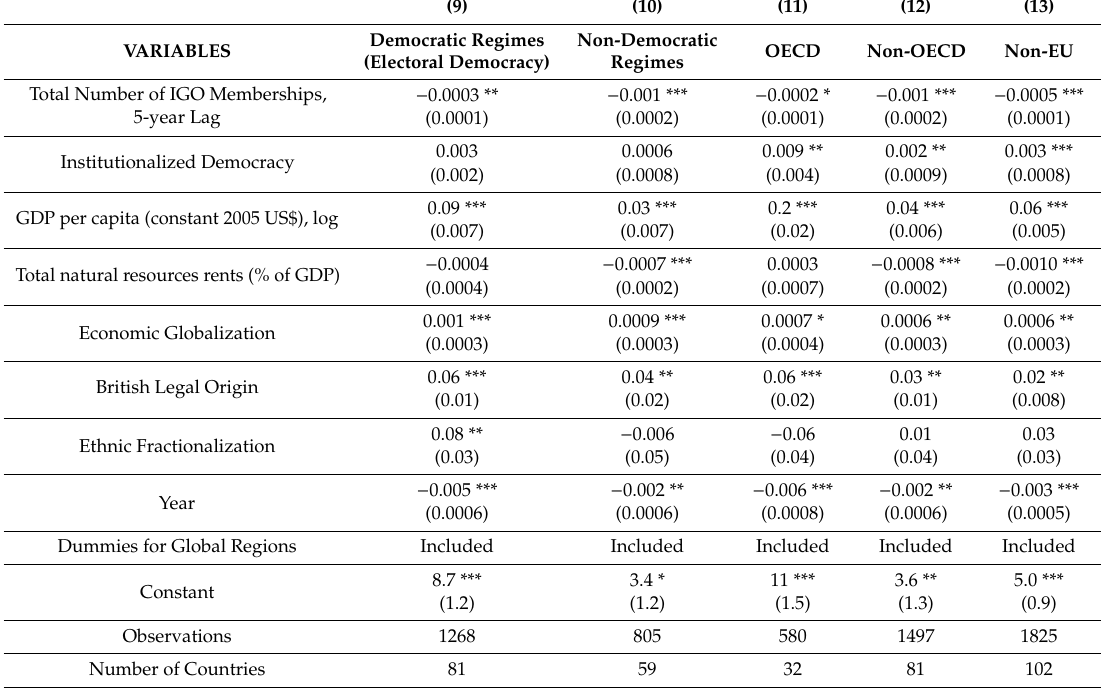
Table 3. Dependent variable: ICRG indicator of quality of government in five subsets, cross-section time-series models, GLS AR(1),